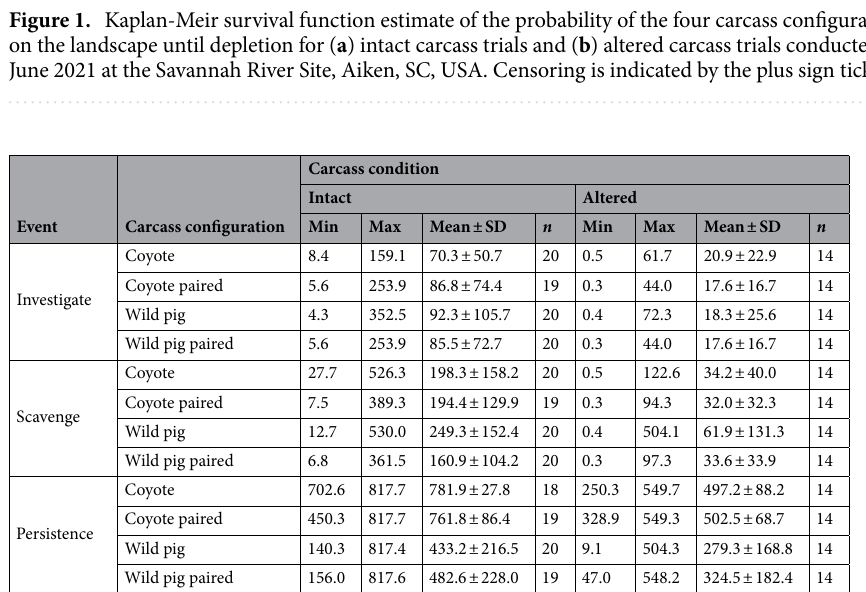
Table 1. The minimum, maximum, and mean persistence times (hours), and associated standard deviations, calculated across carcass configurations for intact and altered carcasses based on scavenging trials completed between February–June 2021 at the Savannah River Site in Aiken, SC,